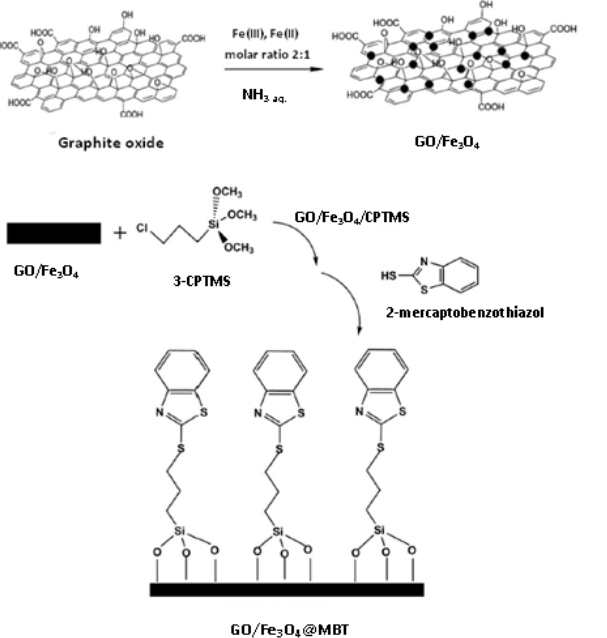
Figure 4. A schematic diagram for the synthesis of 2-mercaptobenzothiazole modified GO/Fe 3 O 4 nanocomposite [59].